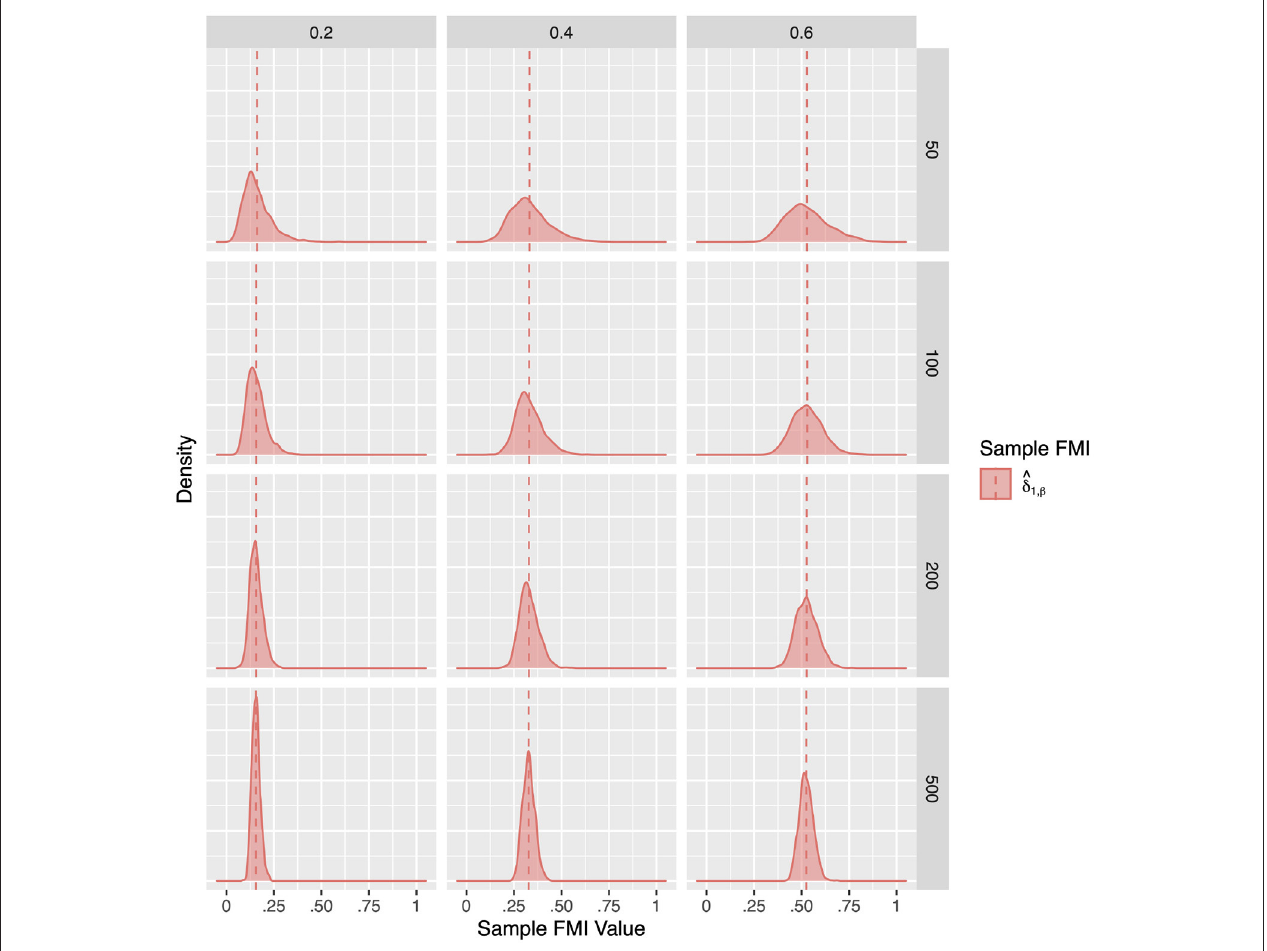
FIGURE 1 | The sampling distribution of FMI for regression coefficients in MCAR. The panel rows correspond to sample sizes of N panel columns correspond to per variable missing rates of 20, 40, and 60%, or overall population missing rates of 10, 20, and 30%. The population FMI value in each panel is given as a vertical black dotted line. The sampling distributions of the three estimates are virtually identical in simple